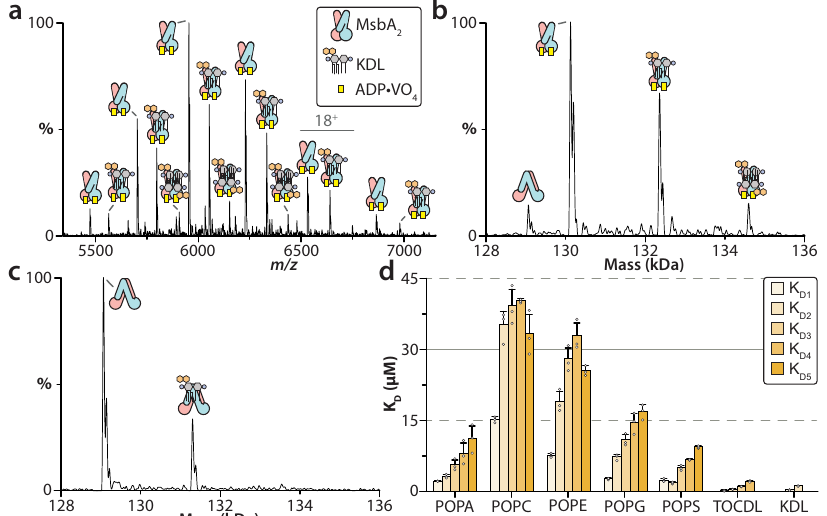
Fig.3|BiophysicalcharacterizationoflipidbindingtoMsbAtrappedwithADP and vanadate. a Representative mass spectrum of MsbA trapped with ADP·VO 4 andinthepresenceof0.4 μ MKDL. b Deconvolutionofthemassspectrumshownin panel a . c Deconvoluted mass spectrum of non-trapped MsbA in the presence of